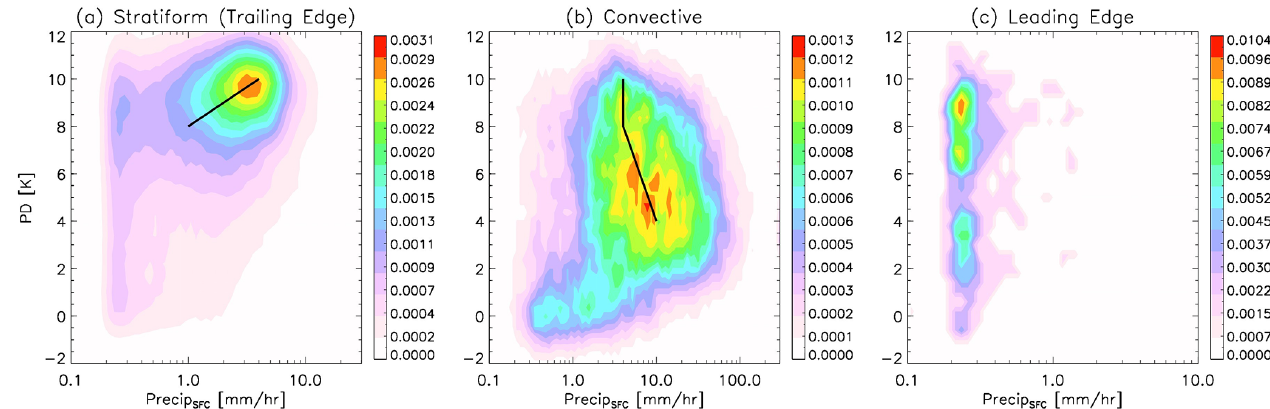
Figure 10. Joint surface precipitation and 166GHz PD distribution function (2D PDF) in the (a) stratiform, (b) convective and (c) leading edge of the squall lines. DPR stratiform, convective and other flags are employed to differentiate different precipitation